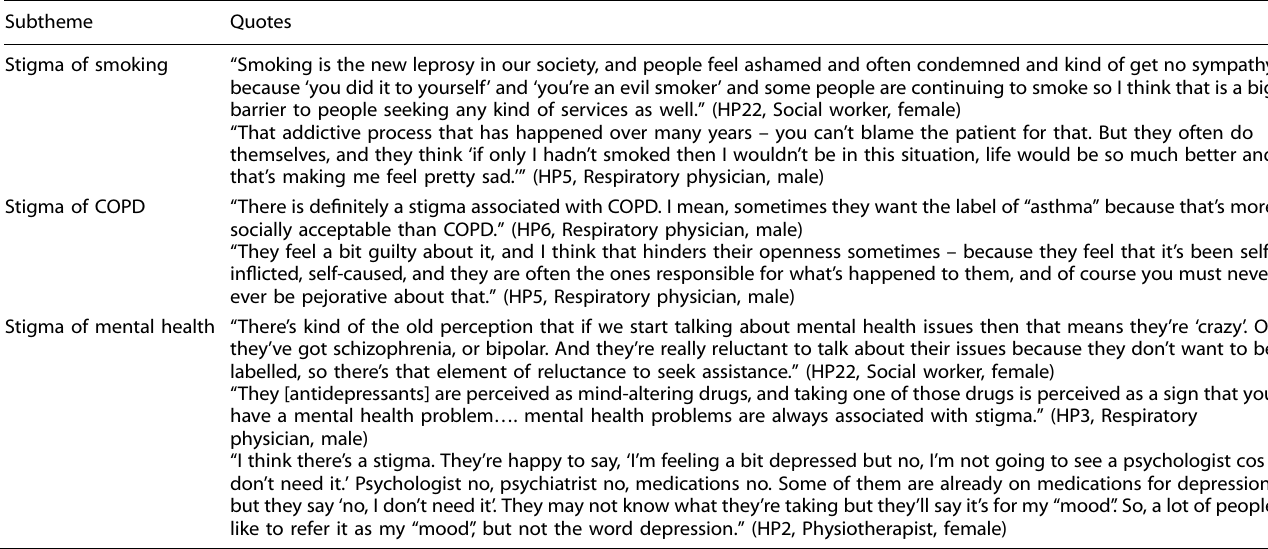
Table 4. Community views and stigma.